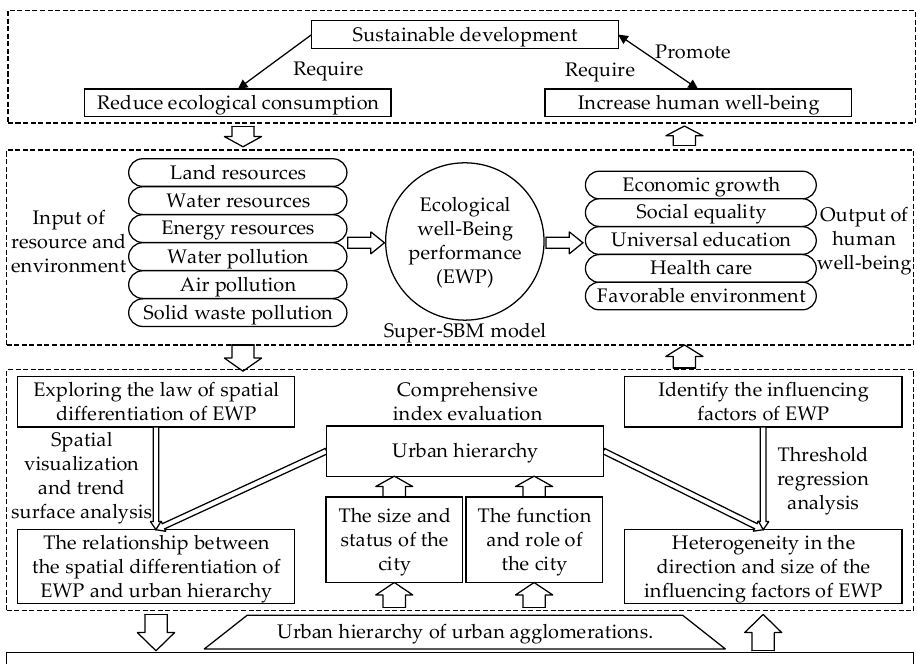
Figure 2. A research framework on spatial differentiation and influencing factors of EWP in urban agglomerations from a hierarchical